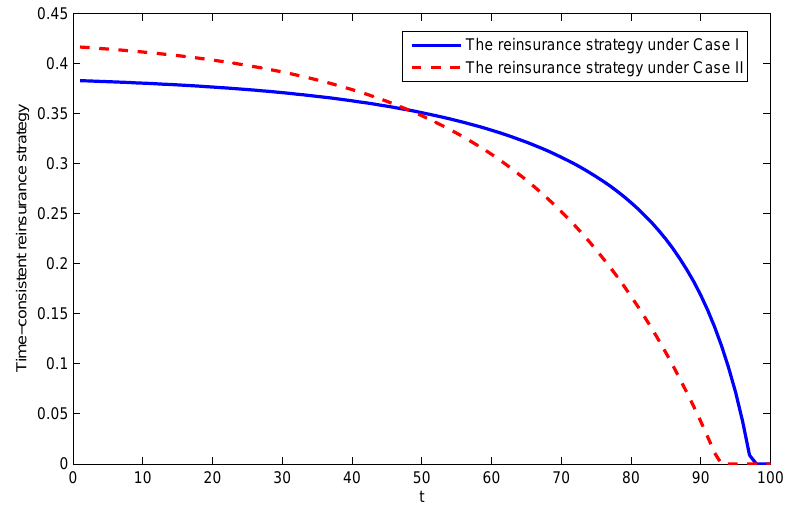
Figure 7. Time-consistent reinsurance strategy under the expected value principle ( α = 0.4 and T =